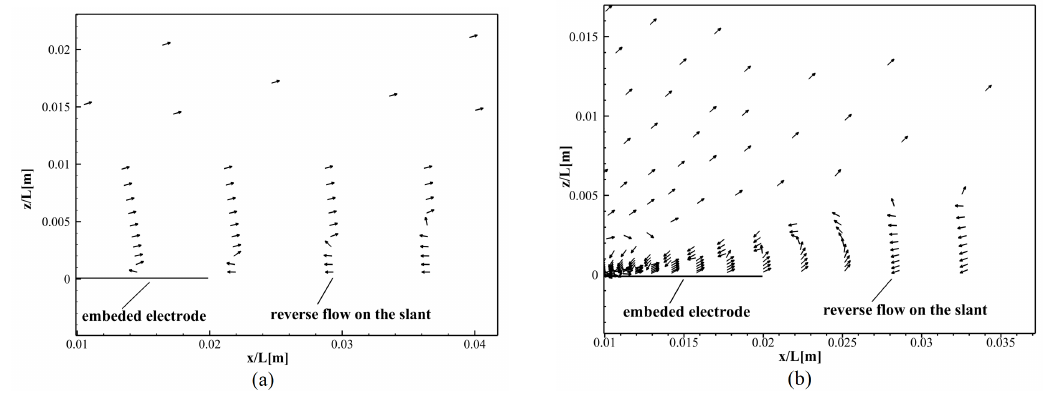
Figure 11. Velocity vector plot over actuator region for 35 ◦ slant angle case 2. ( a ) actuator off, ( b ) actuator